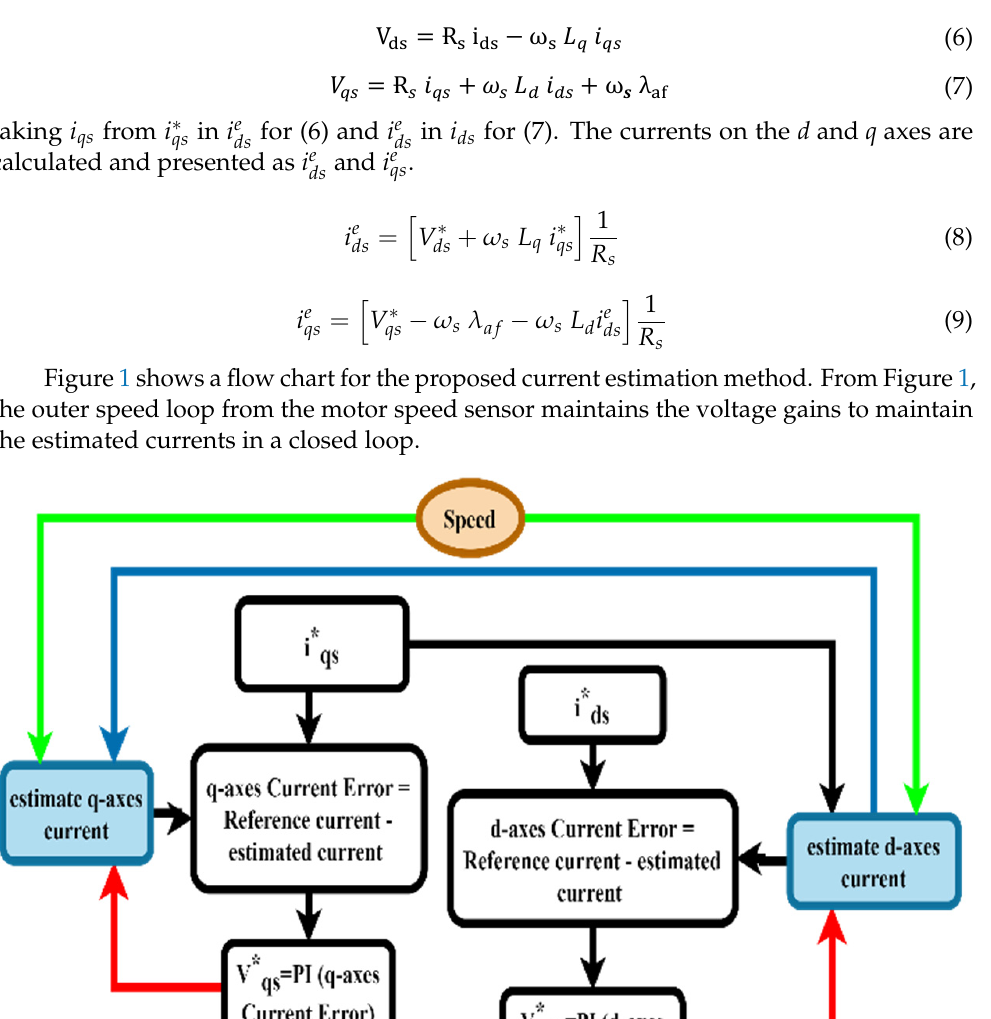
Figure 1. Flow chart for the current estimation method.